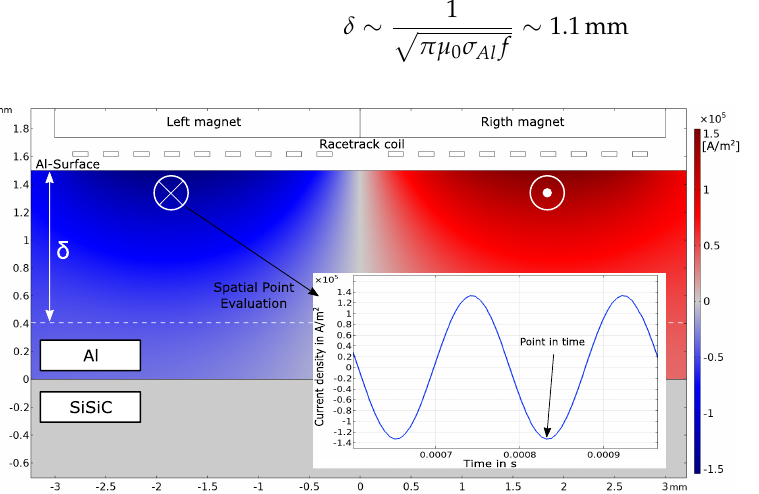
Figure 7. Simulation of the induced eddy current density inside the aluminum core of the EMAT. Due to the opposing direction of the driving current through the coil, the eddy currents point in different directions under the left and right part of the coil. Beneath the center of the racetrack coil, the eddy currents cancel each other out. The mandatory amount of eddy current density for an excitation frequency of 5537Hz is within the calculated penetration depth δ according to Equation (2). The induced eddy current density follows the sinusoidal excitation current through the racetrack coil over time. As SiSiC is considered an electrical insulator, no eddy currents are induced within the